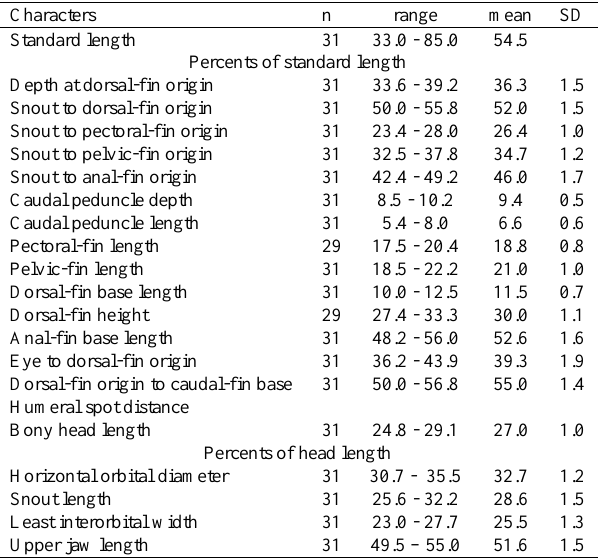
Table 14 . Morphometrics of Charax stenopterus .